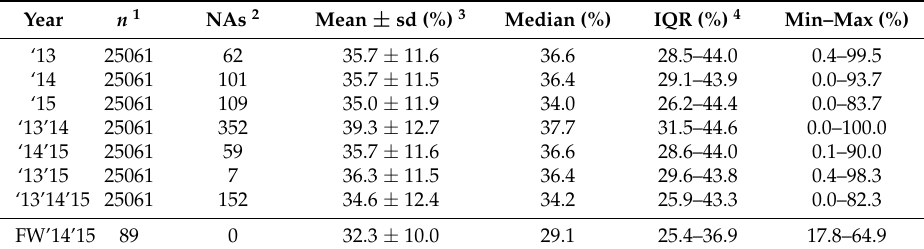
Table 13. Summary statistics of the results of predicted sand percentages of the overlapping bare soil pixels in all three years and of the sand percentages of the field samples (last